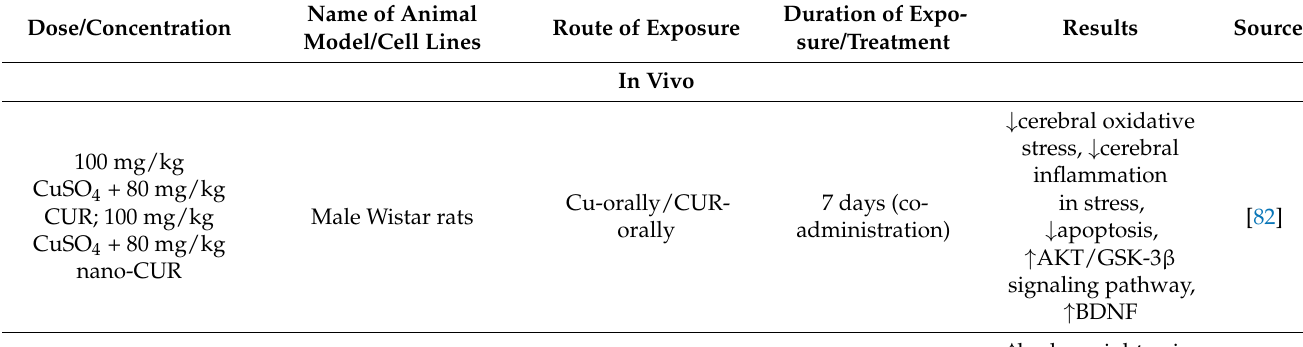
Table 5. Effects of curcumin on copper toxicity based on doses, experimental methods, and